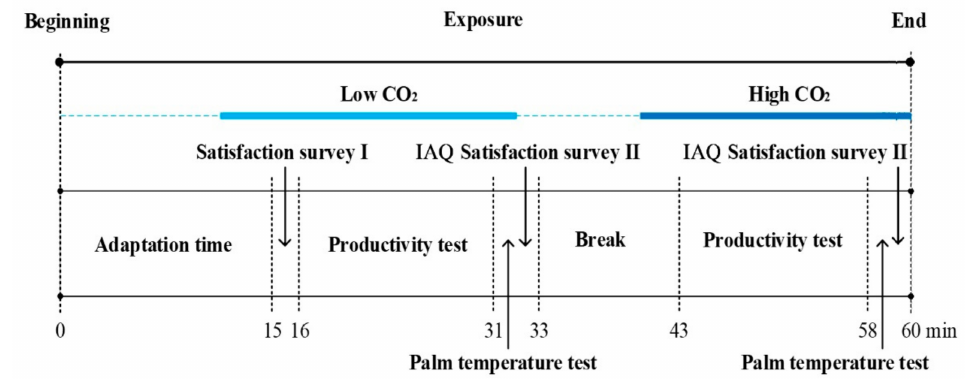
Figure 3. The procedure of each experiment. Note: The timeline is not consistent with the actual time.